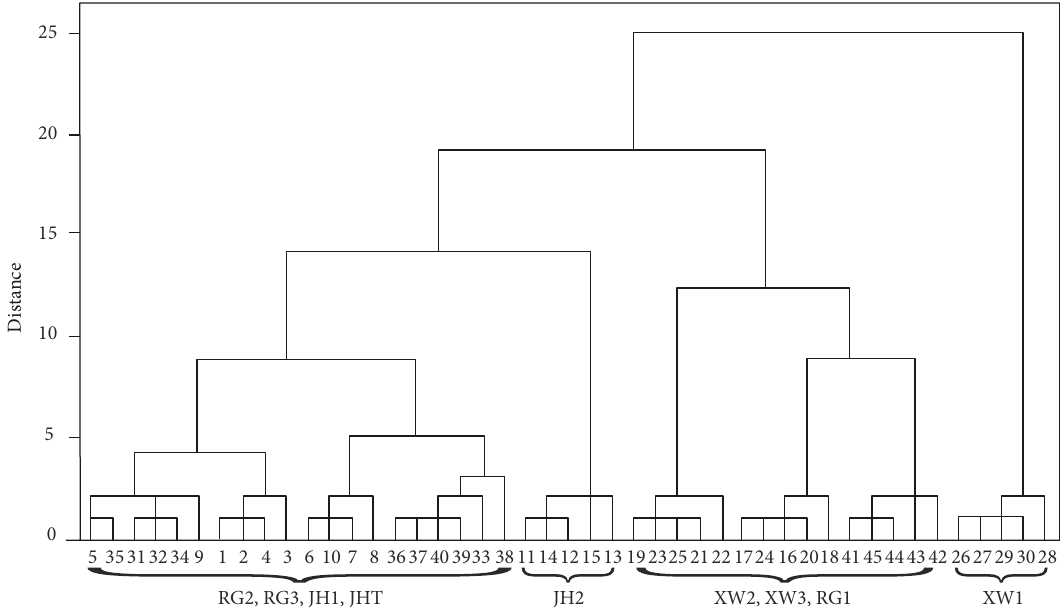
Figure 5: Cluster analysis (CA) chart of three kinds of dry-cured hams by sensory evaluation. JHT: 1-5, JH1: 6-10, JH2: 11-15, XW3: 16-20, XW2: 21-25, XW1: 26-30, RG3: 31-35, RG2: 36-40, and RG1: 41-45. The abbreviations in the figure are referred to in Grades of Ham Samples and Their Abbreviations.